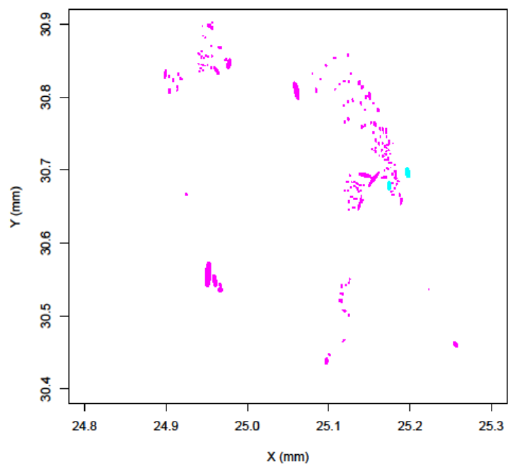
Figure 2: Different shapes, sizes and directions of the inclusions in a steel specimen approximated with ellipses.